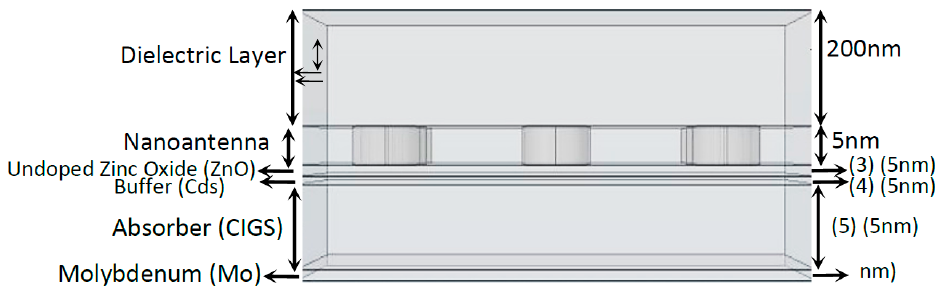
Figure 3. Layout side view of the 3D CIGS solar cell structure with the composition and thickness of each layer.